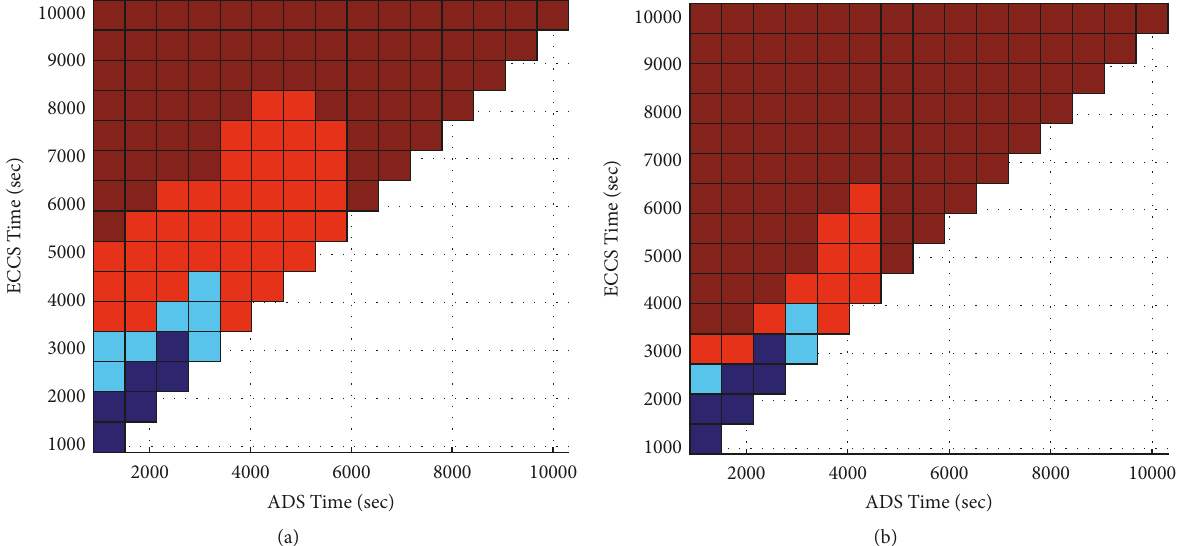
Figure 5: Fuel damage state (a) at the time of water injection (ECCS time) and (b) at the time of transition ( 𝑇 𝑡𝑟 ) as predicted by MELCOR